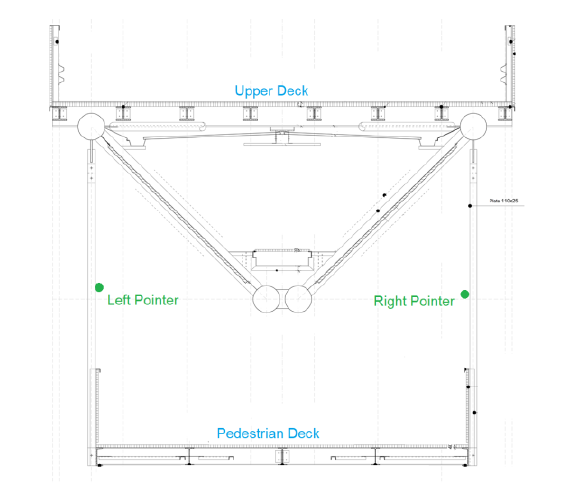
Figure 4. Cross section of the bridge deck. The laser pointers are fixed to the plates used to hang the pedestrian